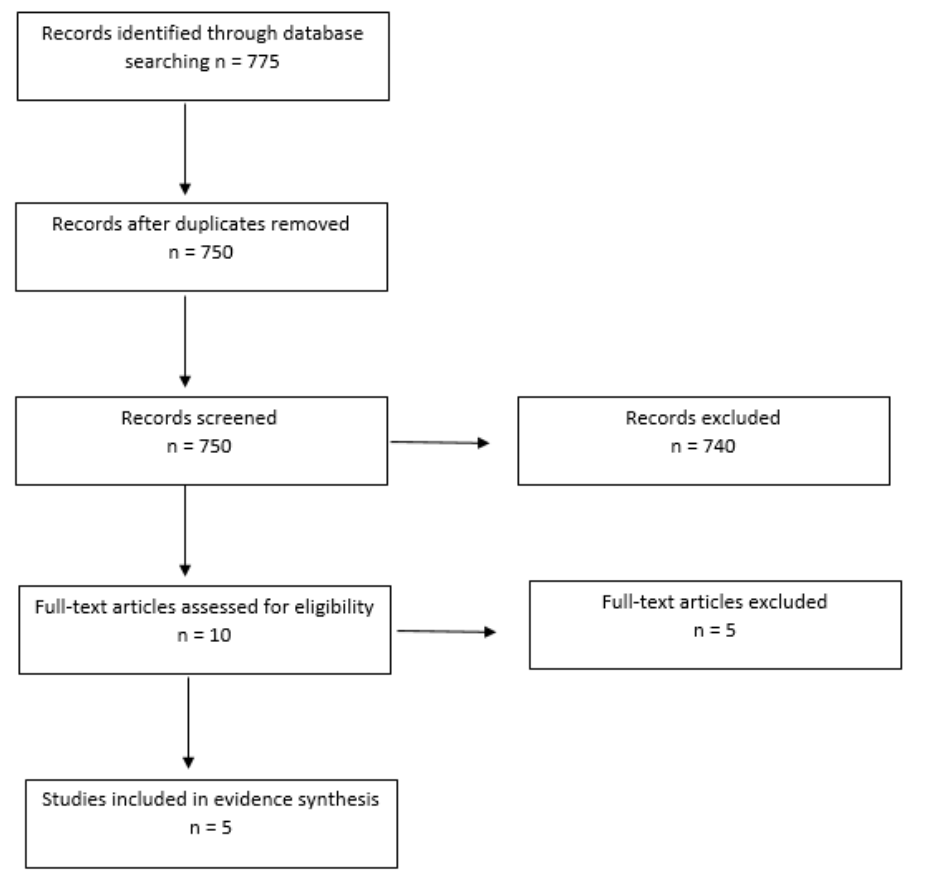
Figure 1. Flow chart of the literature selection for evidence synthesis.